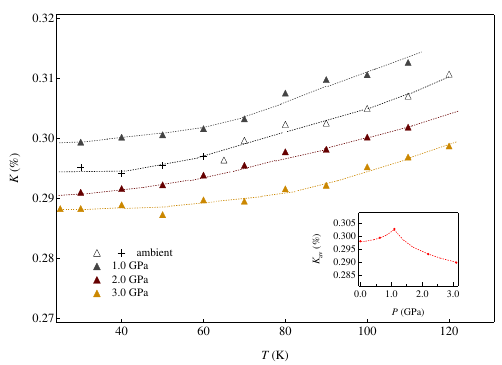
Figure 3: The 77 Se shift in the non-SC state at several pressures. The average of K a and K b is plotted below 60 K. The inset shows the 77 Se shift at 70 K, reflecting the pressure dependence of the DOS.